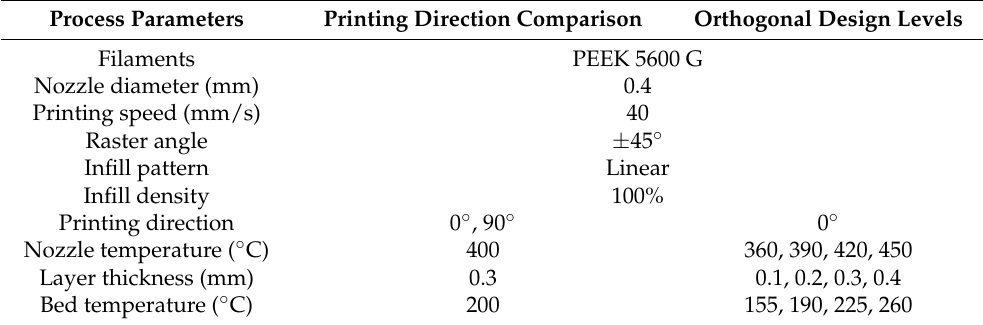
Table 2. AM process parameters.